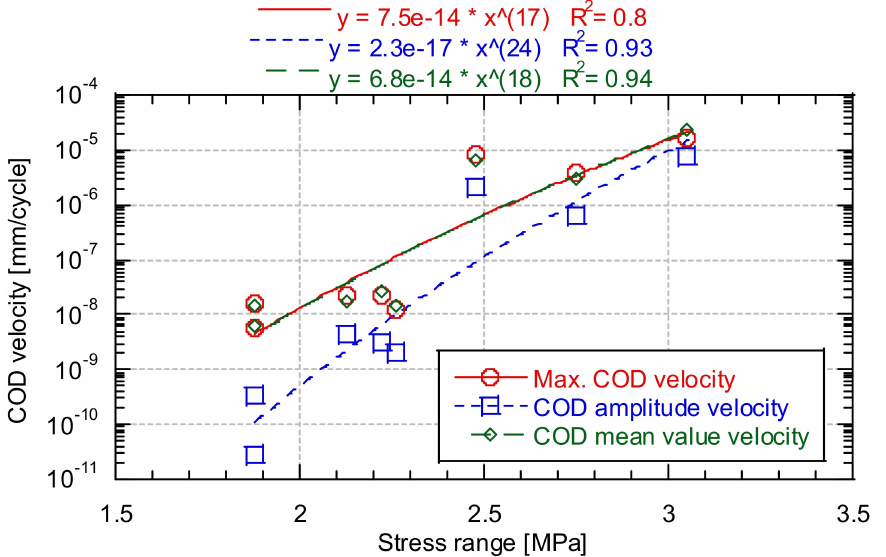
Figure 16. COD velocity as a function of the test stress range.